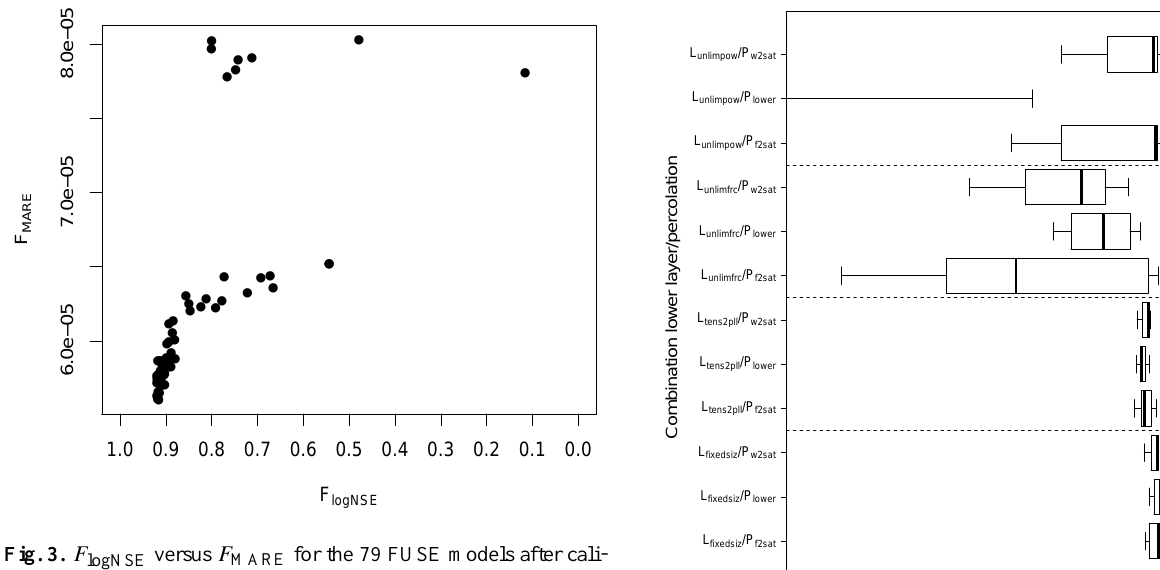
S tmdl (Fig. 5c and e) show convex or concave